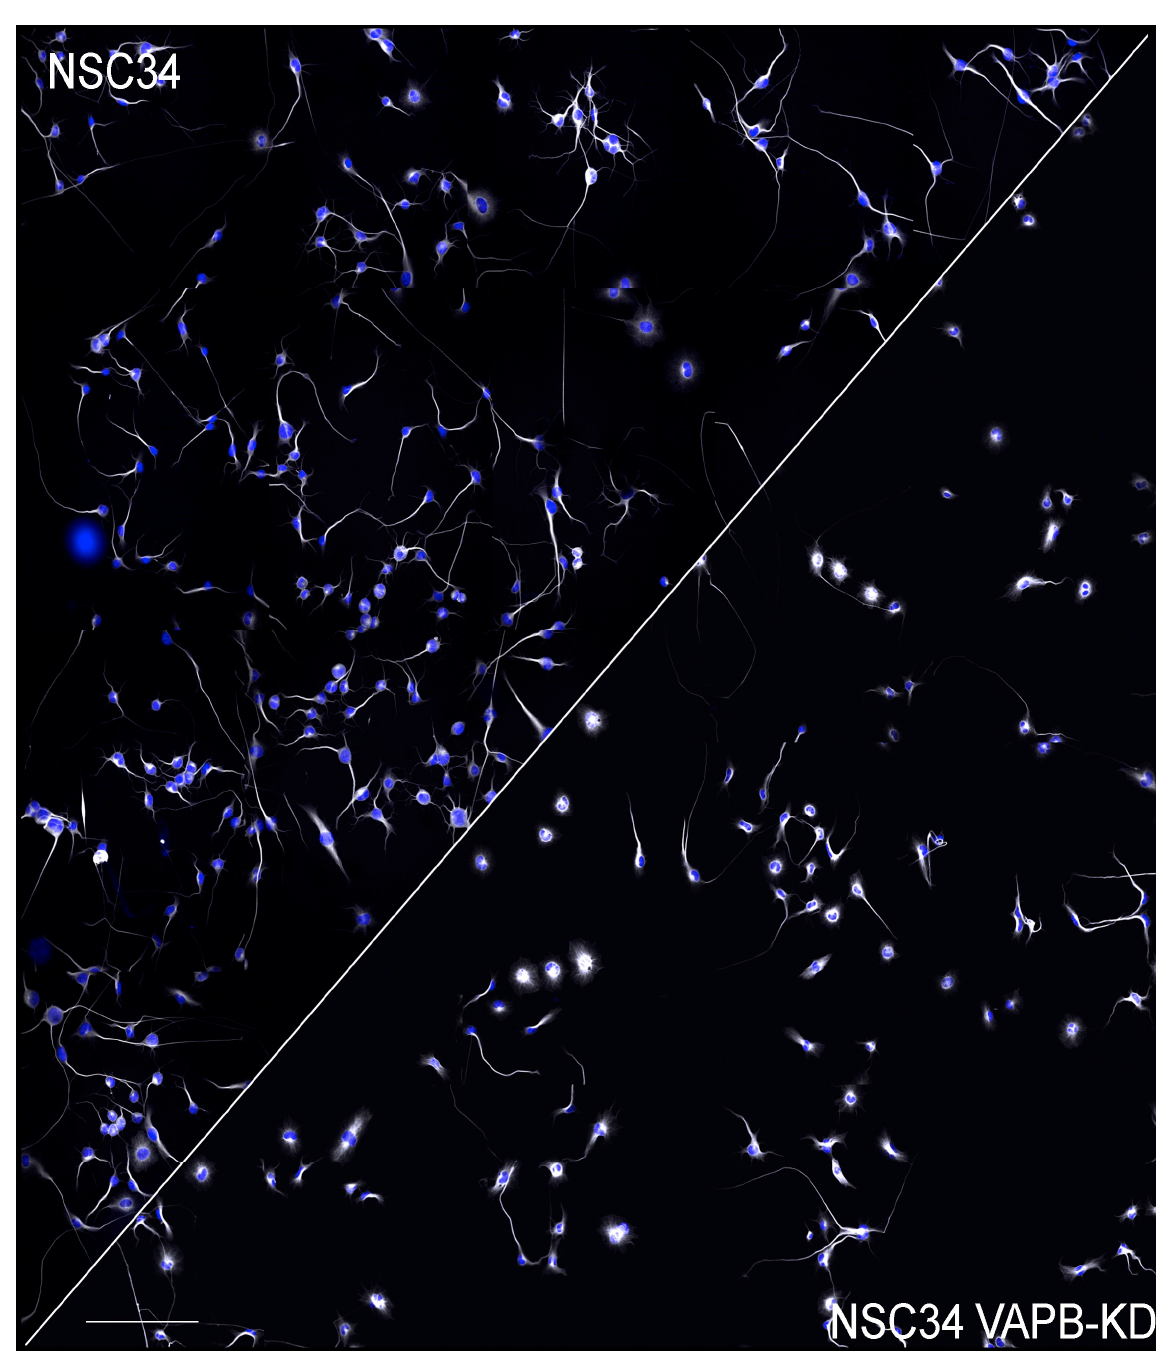
Figure 3. Delayed neurite elongation in NSC34 cells with downregulated VAPB. Low magnification fields of control (left) and VAPB -dsilenced NSC34 cells allowed to differentiate for 3 days. Nuclei are shown in blue and tubulin staining is in greyscale. The image of the control cells is reproduced from [94]. The reader is referred to that publication for details. Scale bar, 300 µ